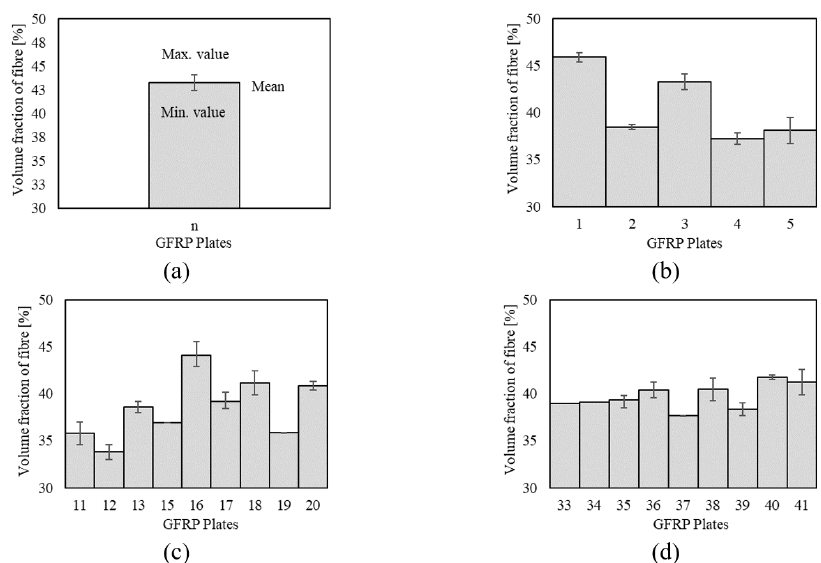
Figure 11. Volume fraction of fibre: (a) description of the constituent parts of the graphics; (b) Group 01; (c) Group 02; (d) Group 03.